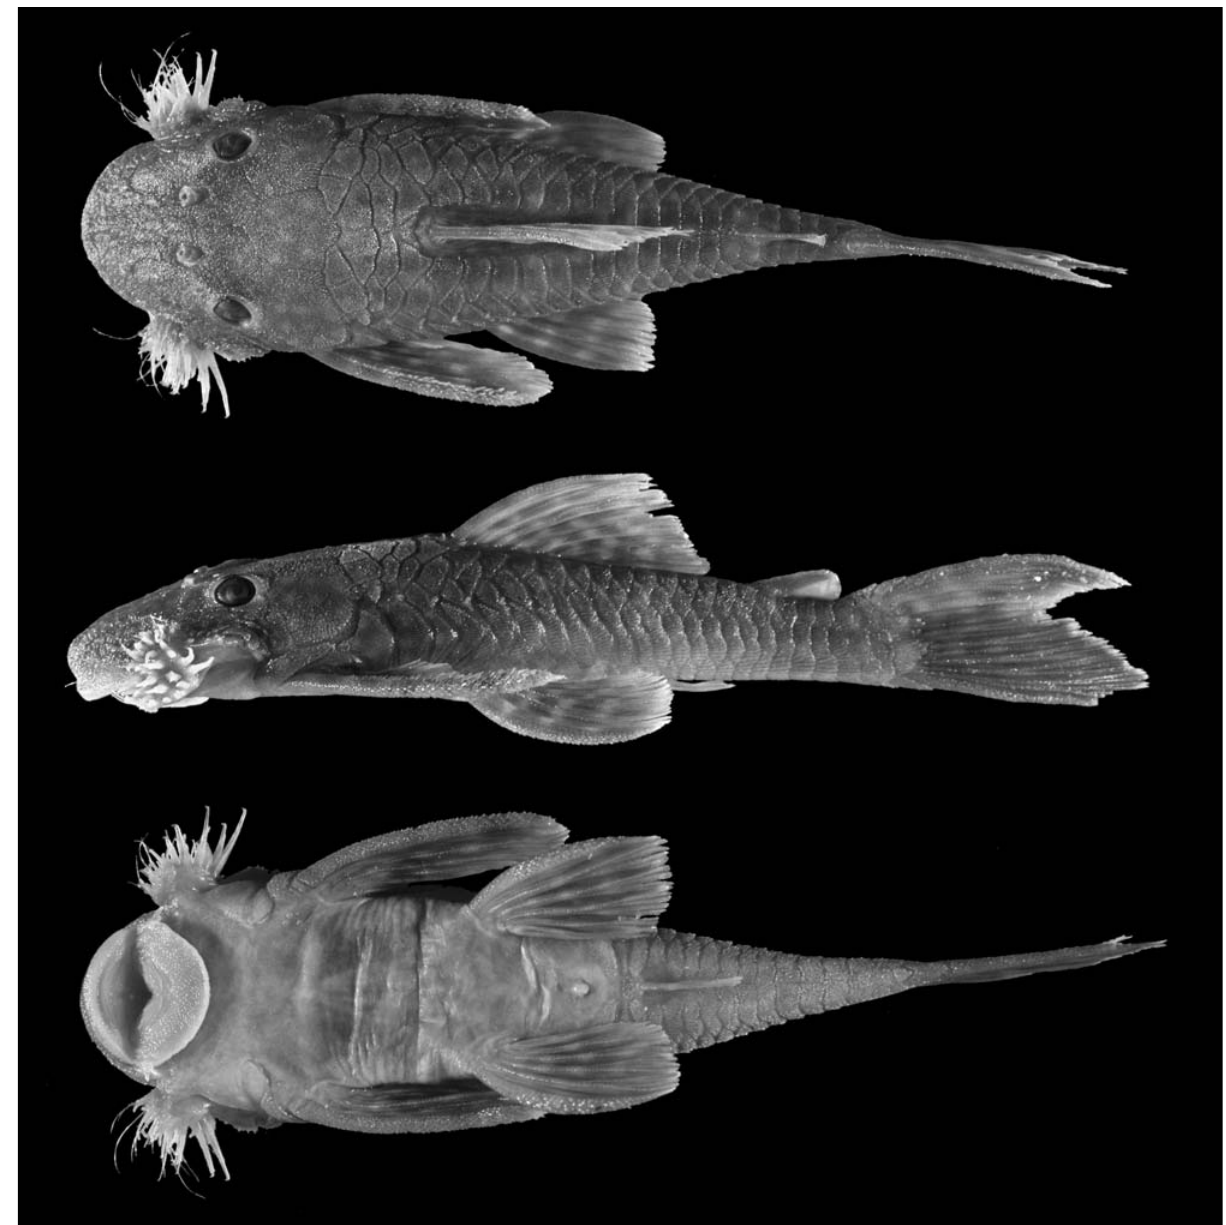
Fig. 5. Dorsal, lateral, and ventral views of Lasiancistrus guacharote , AUM 22136, 80.1 mm having black spots in the dorsal fin ( vs. no or white spots) and black bands in the paired and caudal fins ( vs. bands absent). Description. See genus description for more information.